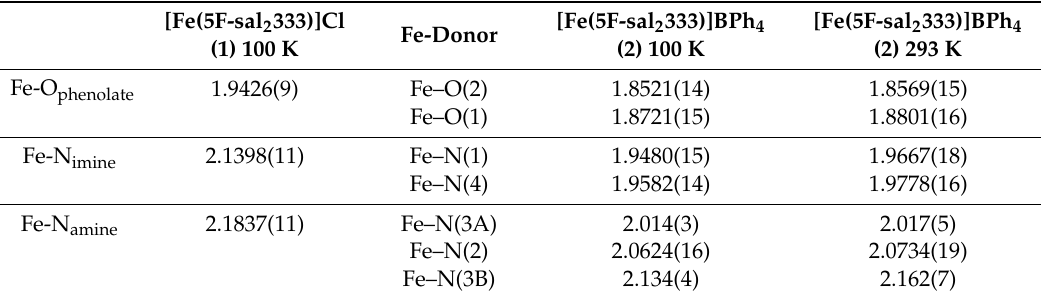
Table 2. Bond length data for complexes 1 and 2 .